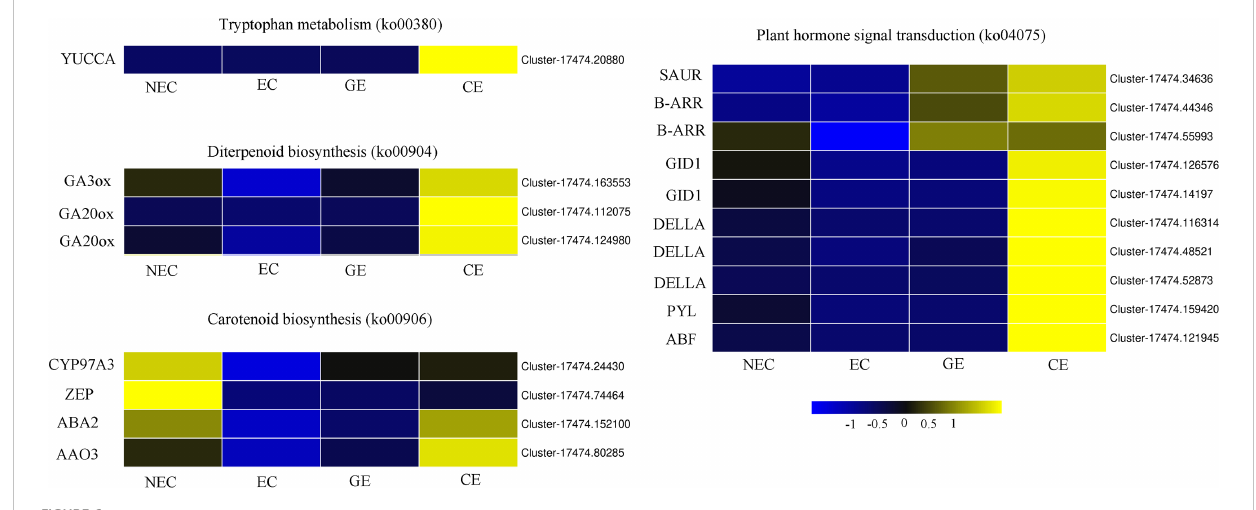
FIGURE 6 Differentially expressed genes of endogenous hormone biosynthesis and signal transduction in O. henryi .